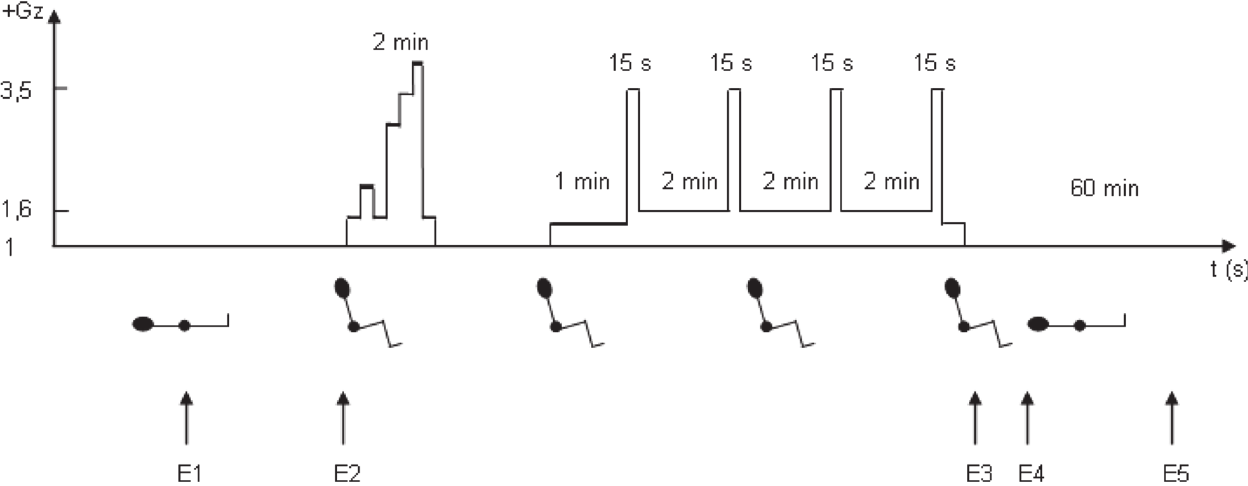
Fig 1. Schematic representation of the protocol. The subject, equipped with anti-G trousers, was exposed to +Gz accelerations during two centrifuge runs (total exposure time: 10 min). Arterial blood pressure was recorded by finger photoplethysmography continuously. Echocardiographic measurements were performed before the runs (E1, supine left lateral, E2, sitting with a 32° backrest angle in the centrifuge gondola), immediately after (E3, sitting in the gondola, E4, supine left lateral) and after 60 min of recovery (E5, supine left lateral). N =